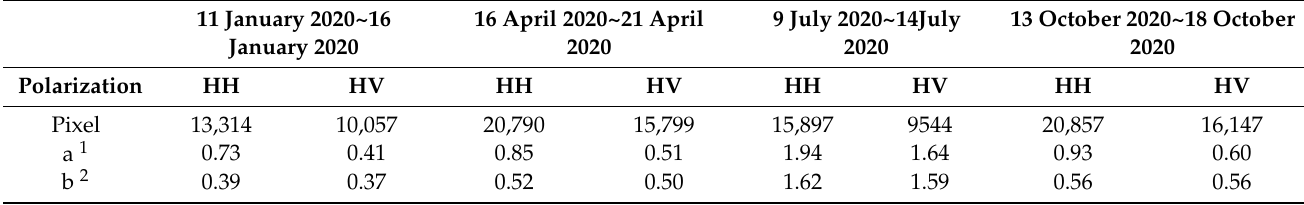
Table 3. RMSE of SAR images mosaics on Greenland ice sheet